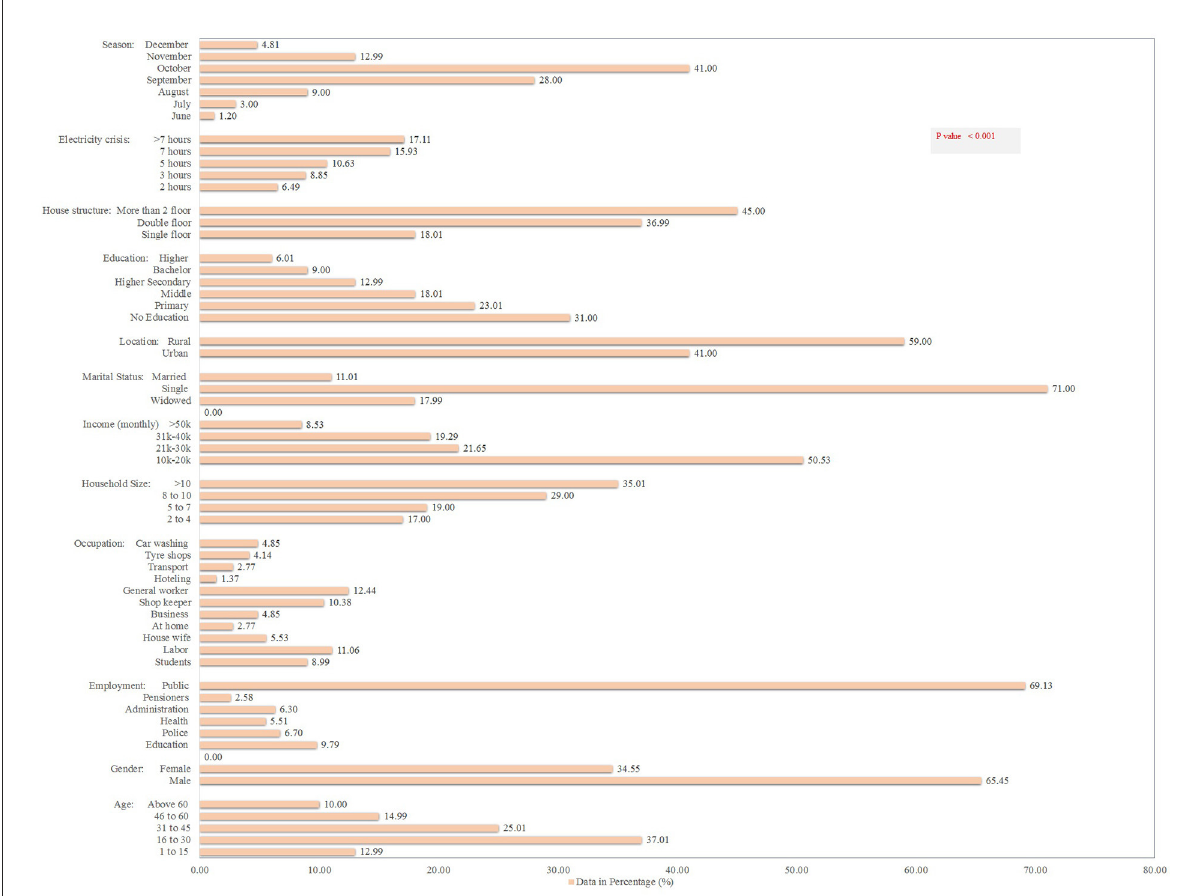
FIGURE3 Socio-demographic determinants and other risk factors for dengue fever in the KP dengue outbreak (2021). Chi-square test was performed; p < 0.05 was considered statistically